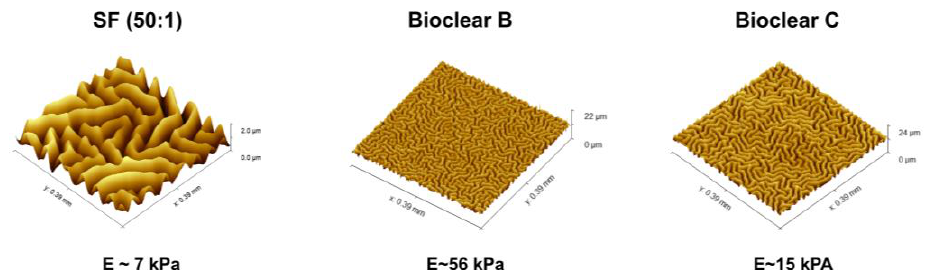
Figure 4. Visualization of the wrinkles. WLI image of the generated wrinkles on SF, Bioclear B, and Bioclear C and their corresponding profile. Images show different z-scales: the height of the wrinkles on SF and Bioclear is similar, but they vary in their lateral dimensions with one wrinkle on SF at approximately 45 µm and 20 µm on Bioclear.